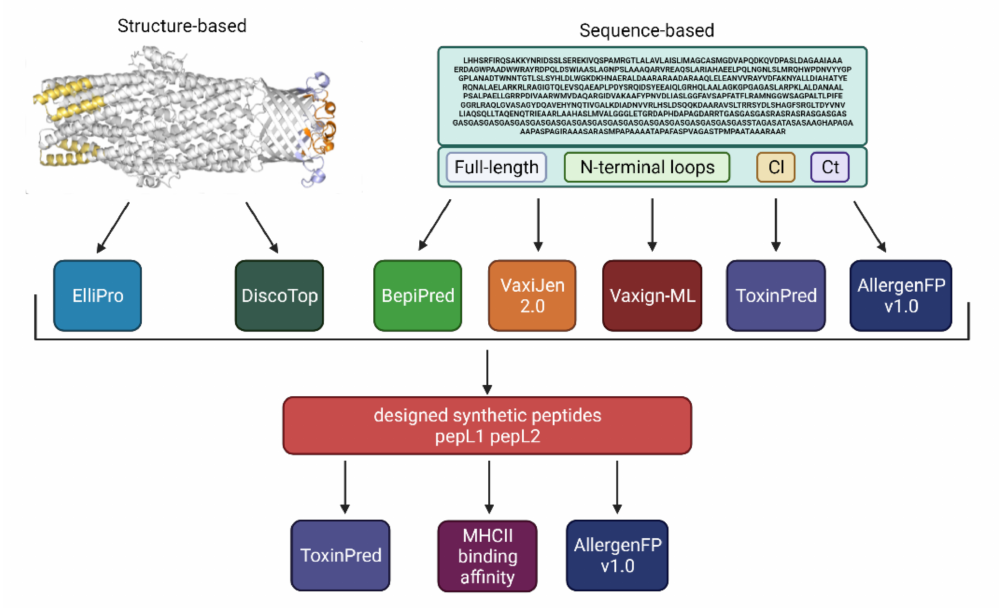
Figure 1. Schematic approach for using bioinformatic tools to predict immunogenic epitopes and their antigenicity, allergenicity, and